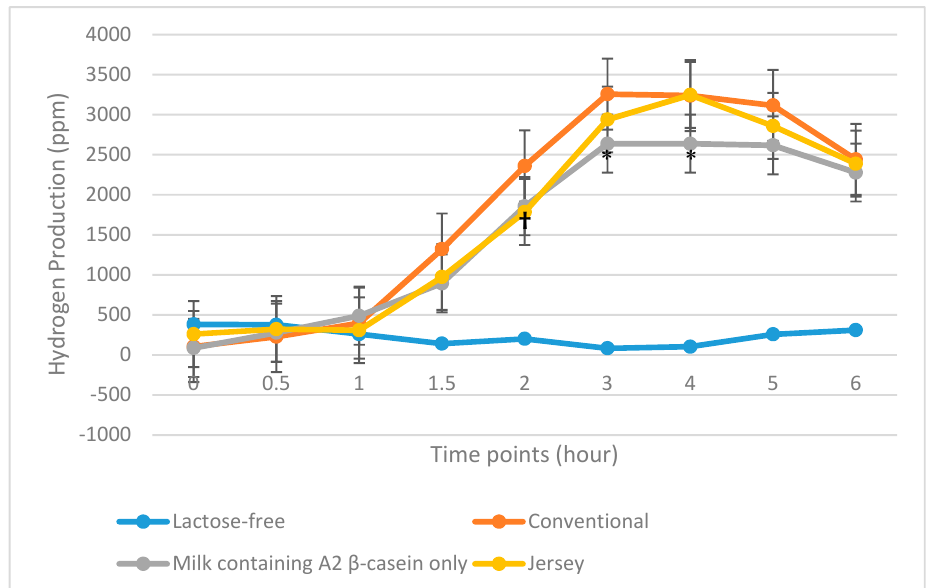
Figure 5. Total hydrogen produced during the 6 h after consuming the four milk products in 33 lactose maldigesters. ppm, parts per million. * p = 0.05, * p = 0.03 for milk containing A2 β -casein only vs. conventional milk at 3 and 4 h, respectively; † p = 0.03 for Jersey milk versus conventional milk at 2 h.